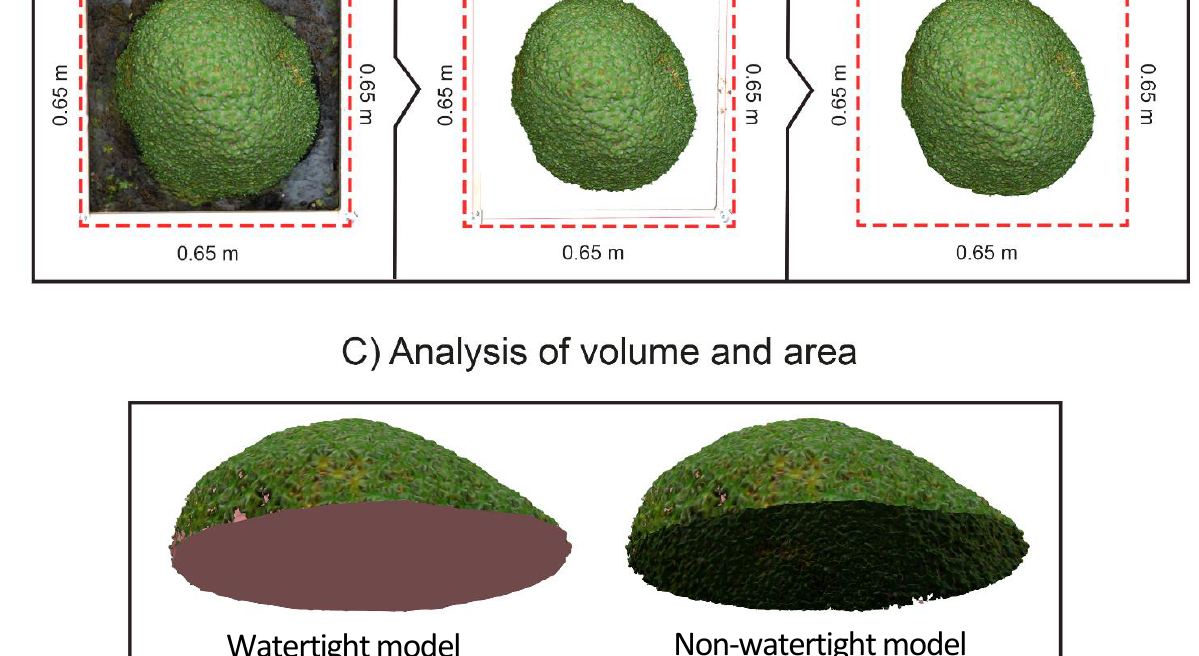
We found a strong relationship between the volume of cushions obtained by the SfM 3D models and their dry biomass ( R = 0.97, p < 0.001, n = 13, Figure 2A). Also, as expected, the volume and area of the cushions had a strong positive relationship ( R = 0.98, p < 0.001, n = 13), as well as the area of cushions and their carbon content ( R = 0.91, p < 0.001, n = 13, Figure